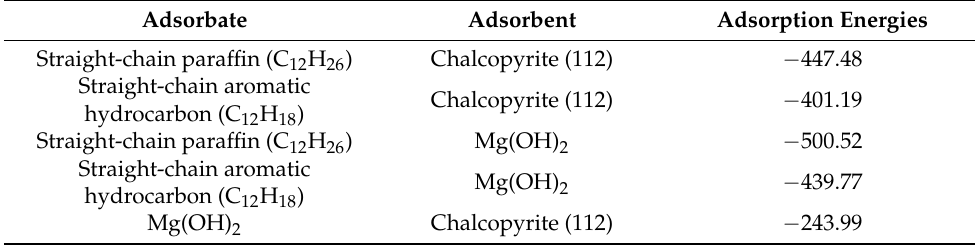
Table 3. The adsorption energies (kJ · mol − 1 ) of various